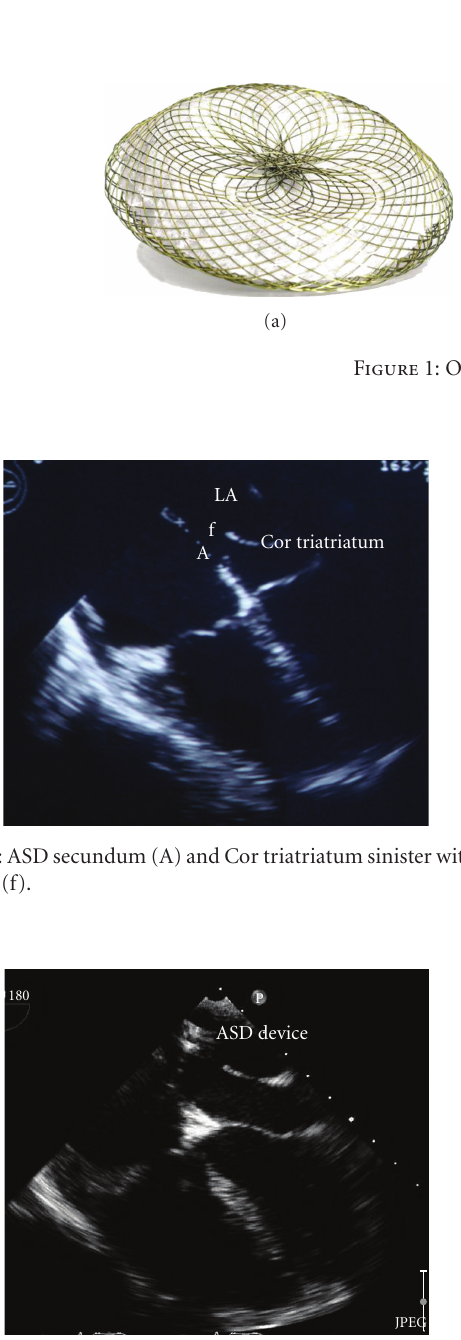
Figure 3: Occlutech Figulla device was deployed.